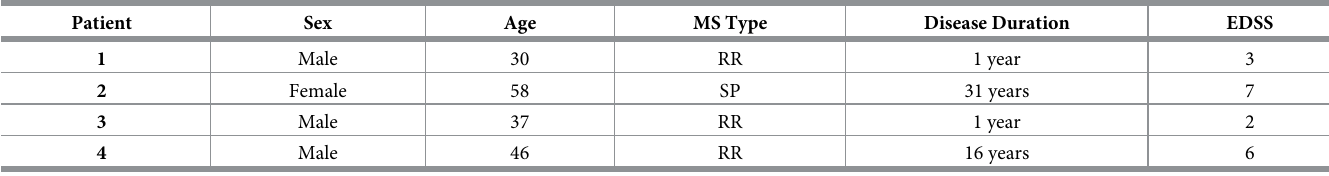
Table 1. Clinical information of multiple sclerosis